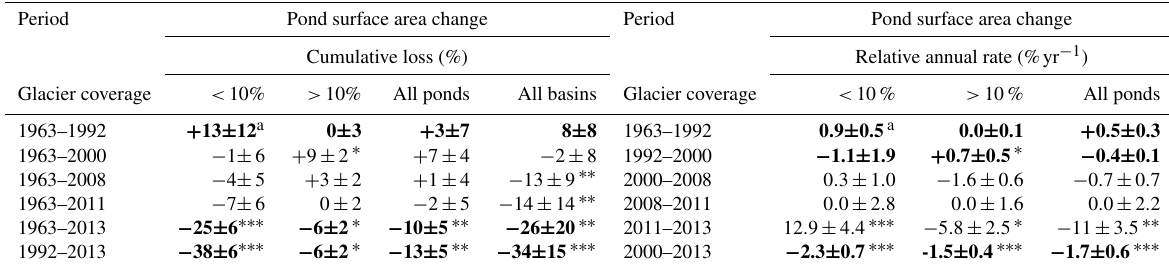
Table 3. General summary of surface area changes related to all 64 considered ponds from 1963 to 2013. The surface area changes of the glaciers located within the basins are also reported. For each comparison the uncertainty of measurement is also shown. On the right the cumulative loss in respect to 1963 is reported for each intermediate period (these data are used for Fig. 8). On the left the relative annual rates are calculated (these data are used for Fig. 7). Bold values represent the main periods of analysis.